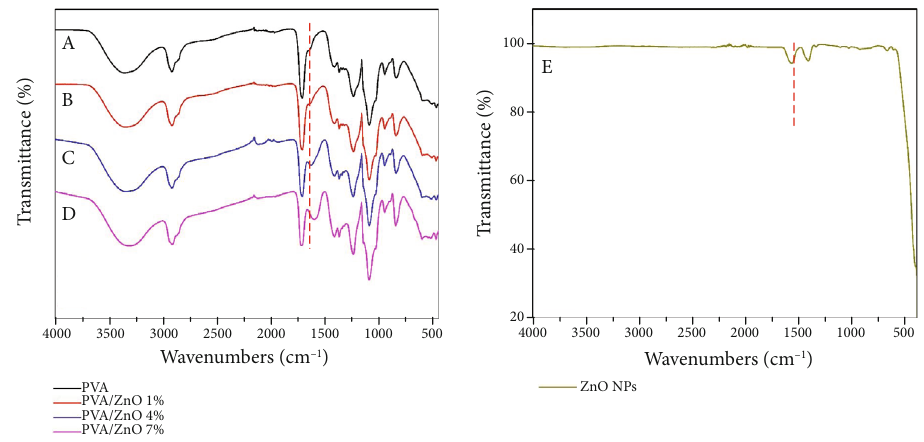
Figure 4: FT-IR spectra of (A) PVA nano fi ber, (B – D) PVA/ZnO nano fi bers, and (E) ZnO